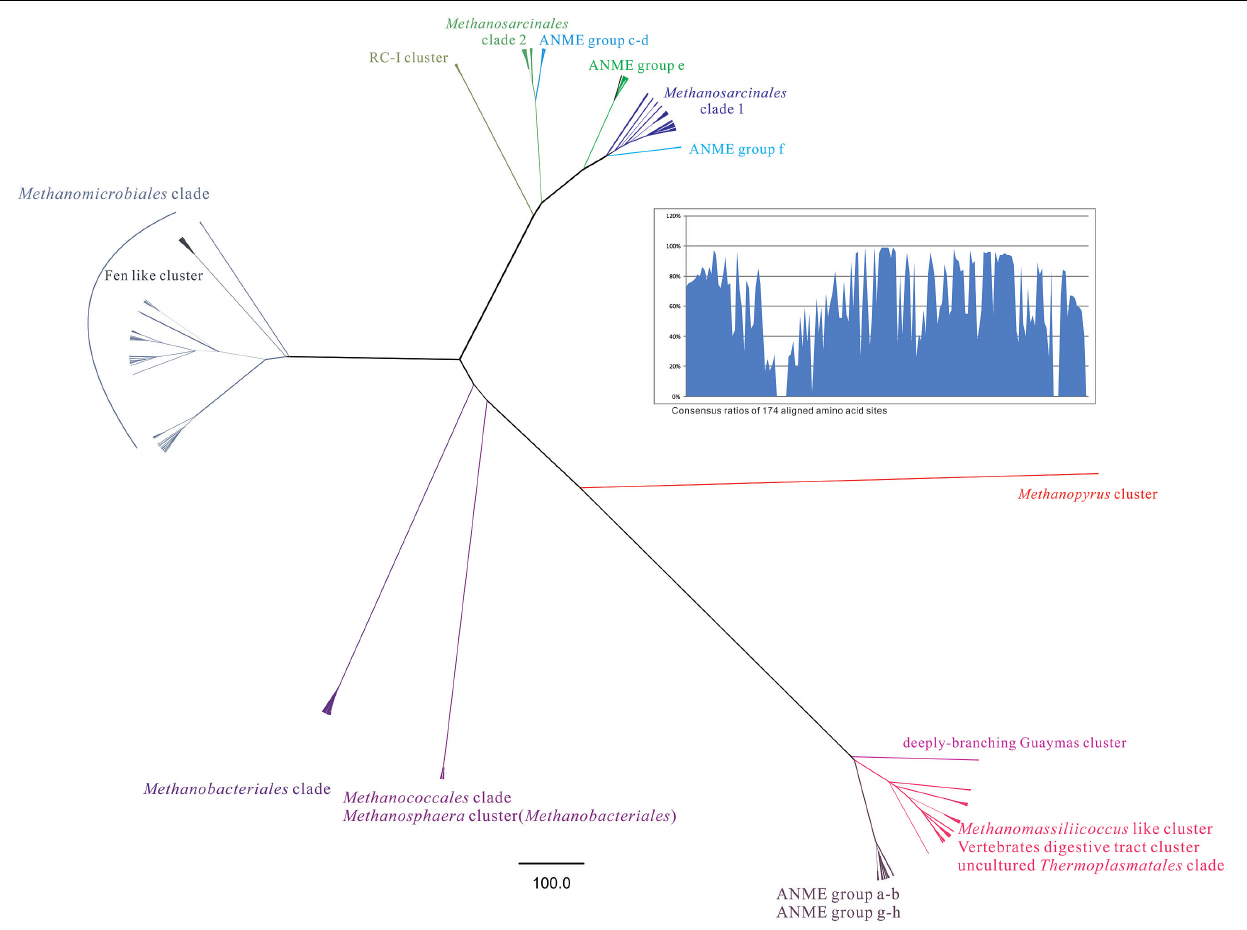
Methanopyrus cluster and its branches were transformed by the proportional method. Scale bar was generated to indicate the phylogenetic distance as changes per amino acid position.The line weight of each branch was determined according to posterior probabilities given by Bayesian interference phylogeny. Each known clade was annotated by distinctive color according to the reference sequences. Consensus ratios of 174 aligned amino acid sites were shown by bar chart on the top right